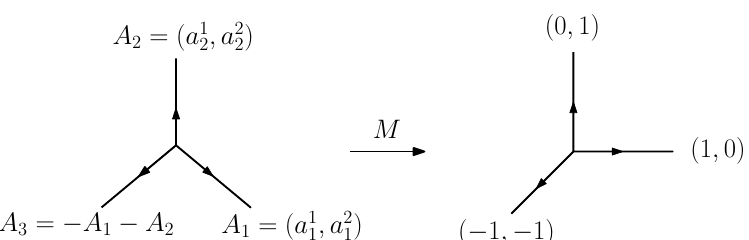
Figure 4. Transformation relating generic vertex of interest with the one used in identi(cid:12)cation of